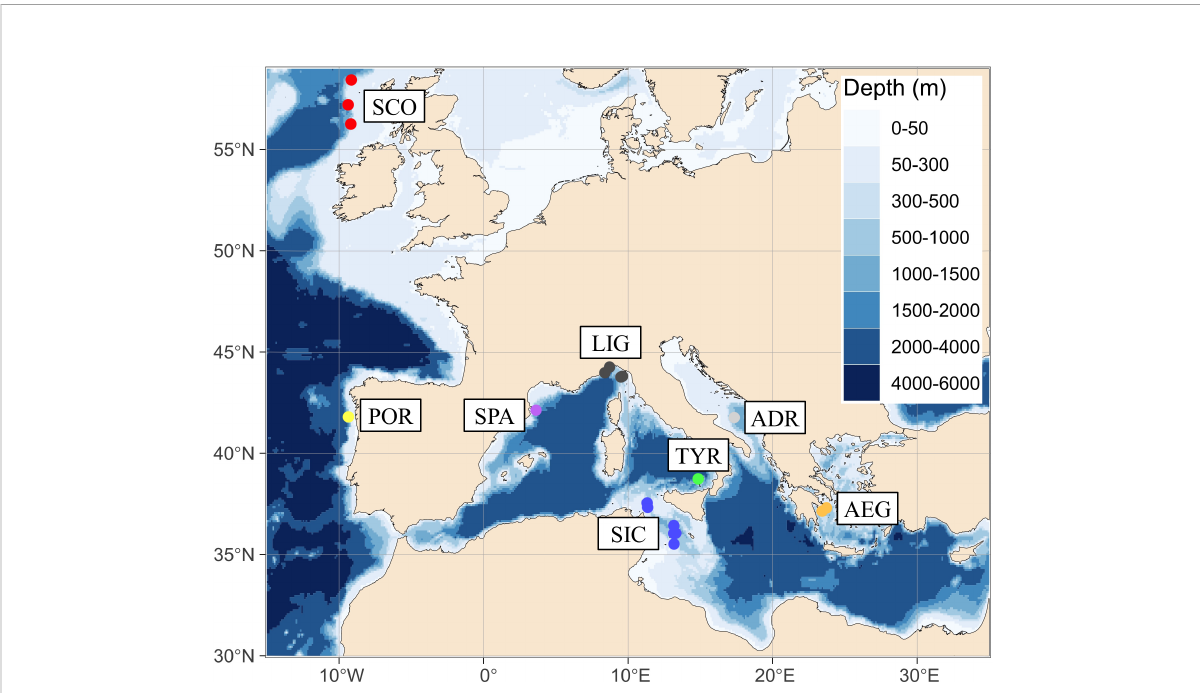
FIGURE 1 Sampling locations of Galeus melastomus . Acronyms of geographical samples are given as in Table 1. Data points are coloured according to the DAPC scatterplot of Figure